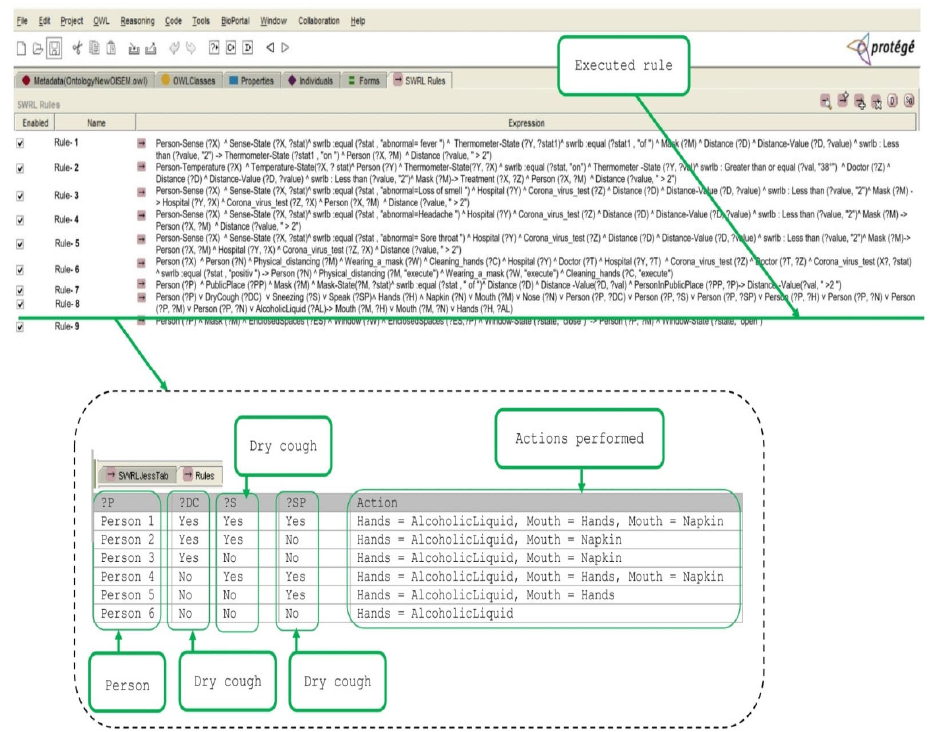
Figure 6. Results of the third scenario. Table 6. Signs and actions of the third scenario.